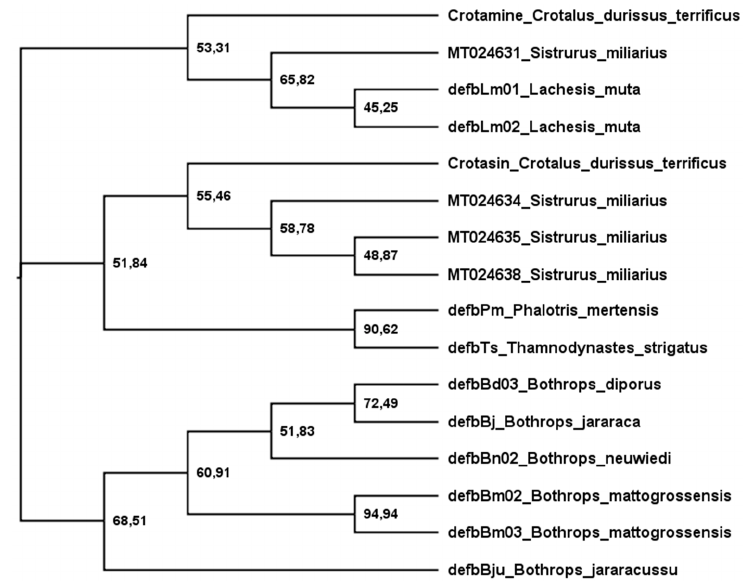
Figure 3. Phylogenetic tree of snake β -defensins. The tree was estimated using translated se- quences and maximum likelihood [153]. The Edge LR-ELW support is shown in each node [154]. Details are described in the Supplementary